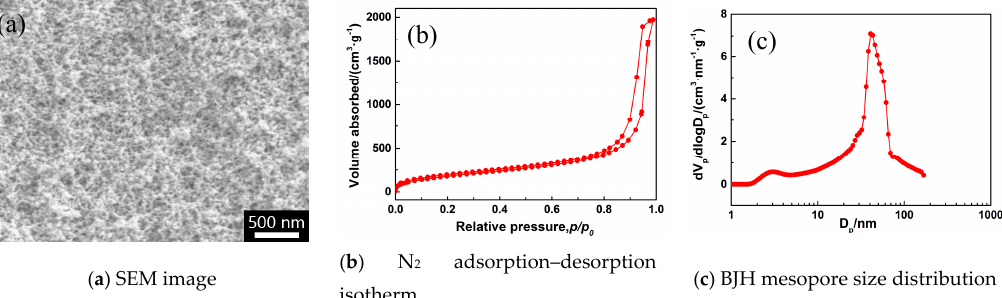
Figure 1. ( a ) SEM image of the synthesized methylsilsesquioxane (MSQ) aerogel and the N 2 adsorption–desorption isotherm ( b ) and Barrett-Joyner-Halenda (BJH) mesopore size distribution ( c ) of the synthesized MSQ aerogel monolith.